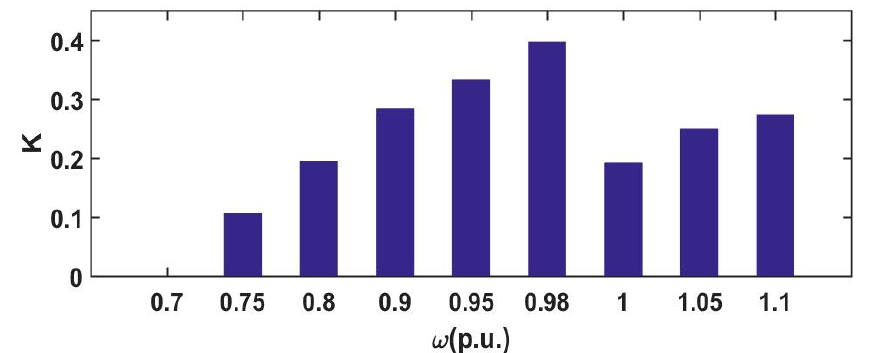
Figure 6. Evaluation index of wind turbines’ inertia response capability. At t = 30 s, the system load is increased by 600 MW. According to [25], in order to keep the ROCOF from exceeding 0.5 Hz/s the minimum inertia requires 30 GW · s. The inertia provided by the synchronous generator in the simulation system was 24.62 GW · s, so the wind turbines needed to provide the left 5.38 GW · s of inertia. According to Equation (20), the average inertia time constant of each wind turbine can be obtained. According to Equation (21), the virtual inertia time constant of each wind turbine is assigned, as shown in Table 3. Table 3. Allocation of virtual inertia of wind turbines. Wind Farm ω /p.u.